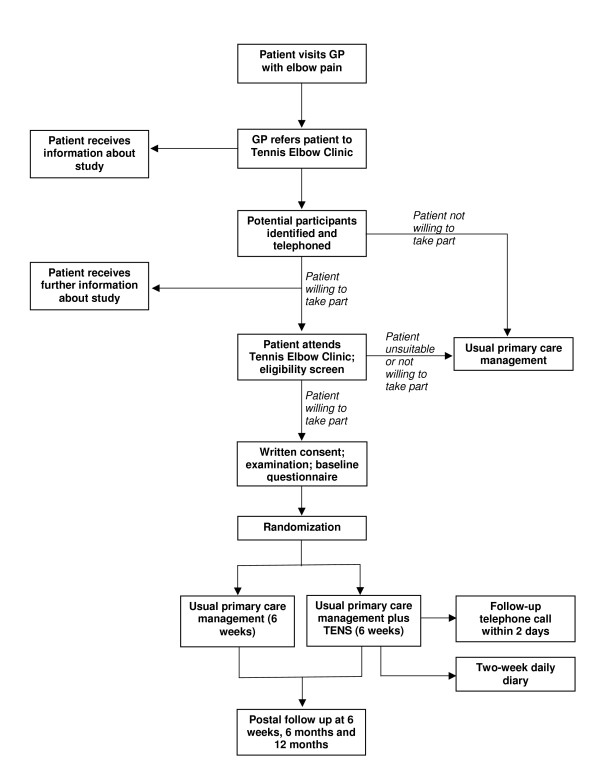
Trial flow chart.